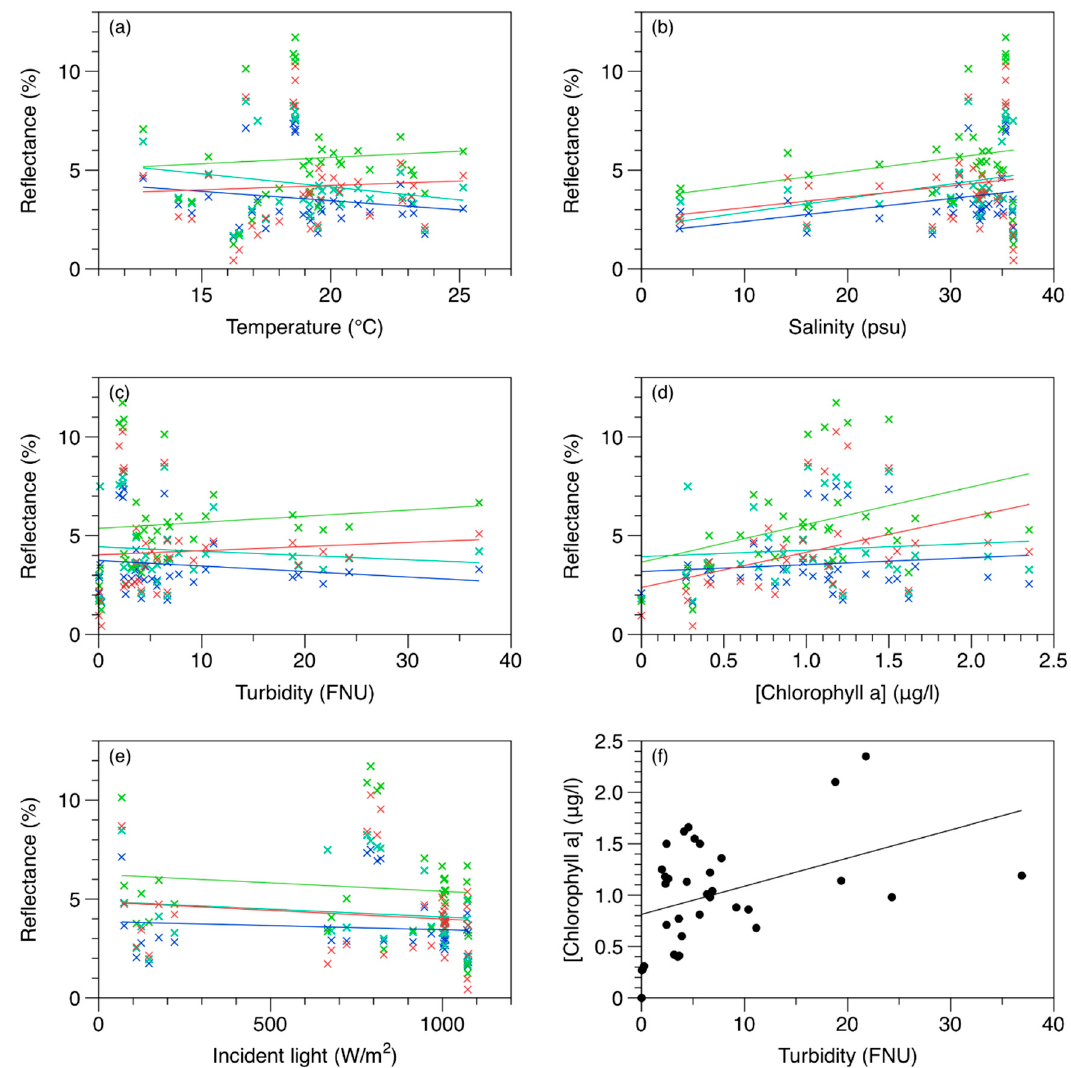
Figure 2. Relationships between reflectance measurements performed at different wavelength bands {448 nm (blue), 494 nm (cyan), 550 nm (green), 675 nm (red)} and environmental variables. From left to right and top to down are represented Reflectance values (in %) as a function of ( a ) Temperature (°C), ( b ) Salinity (psu), ( c ) Turbidity (FNU), ( d ) Chlorophyll a concentration (µg.L − 1 ) and ( e ) Incident light (W.m − 2 ). The last figure (( f ), lower-right) shows the relationship between Turbidity and Chlorophyll a concentration. Linear regressions did not exhibit slopes significantly different from zero (t-tests, d.o.f. = 33, p = 0.05), suggesting both low dependencies and large dispersion of the data.